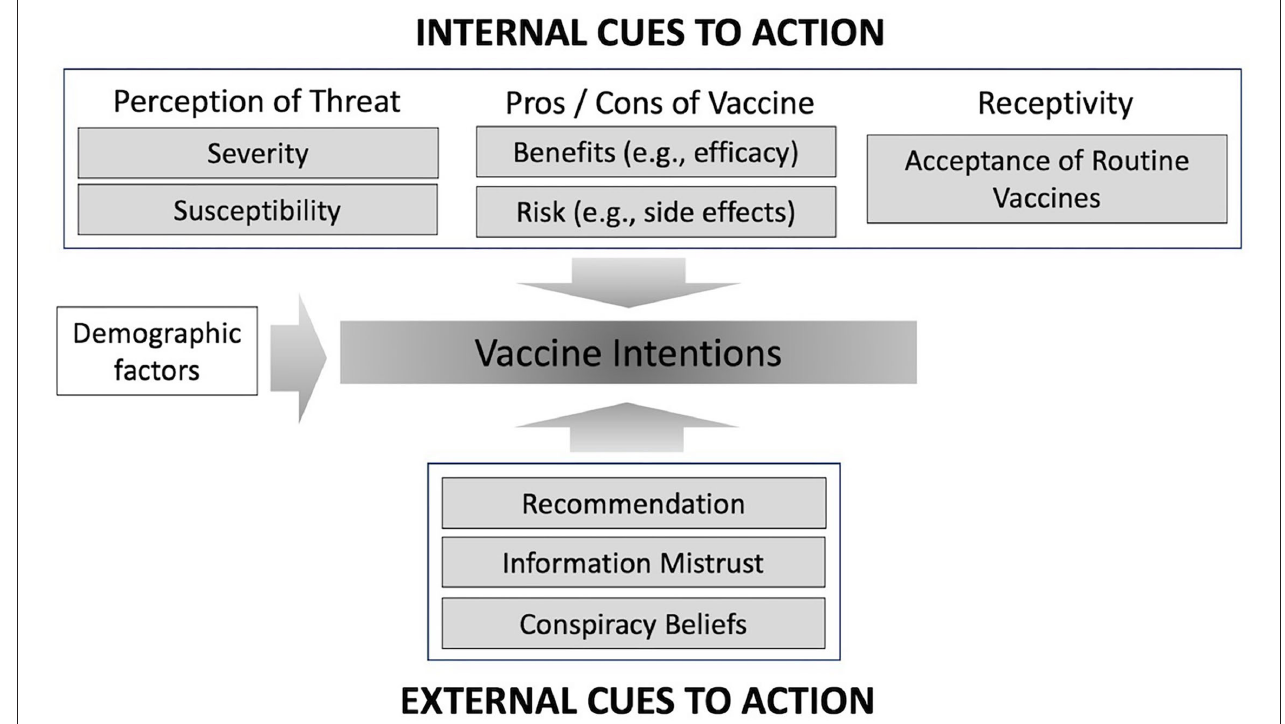
FIGURE 1 | Factors hypothesized to be associated with COVID-19 vaccine